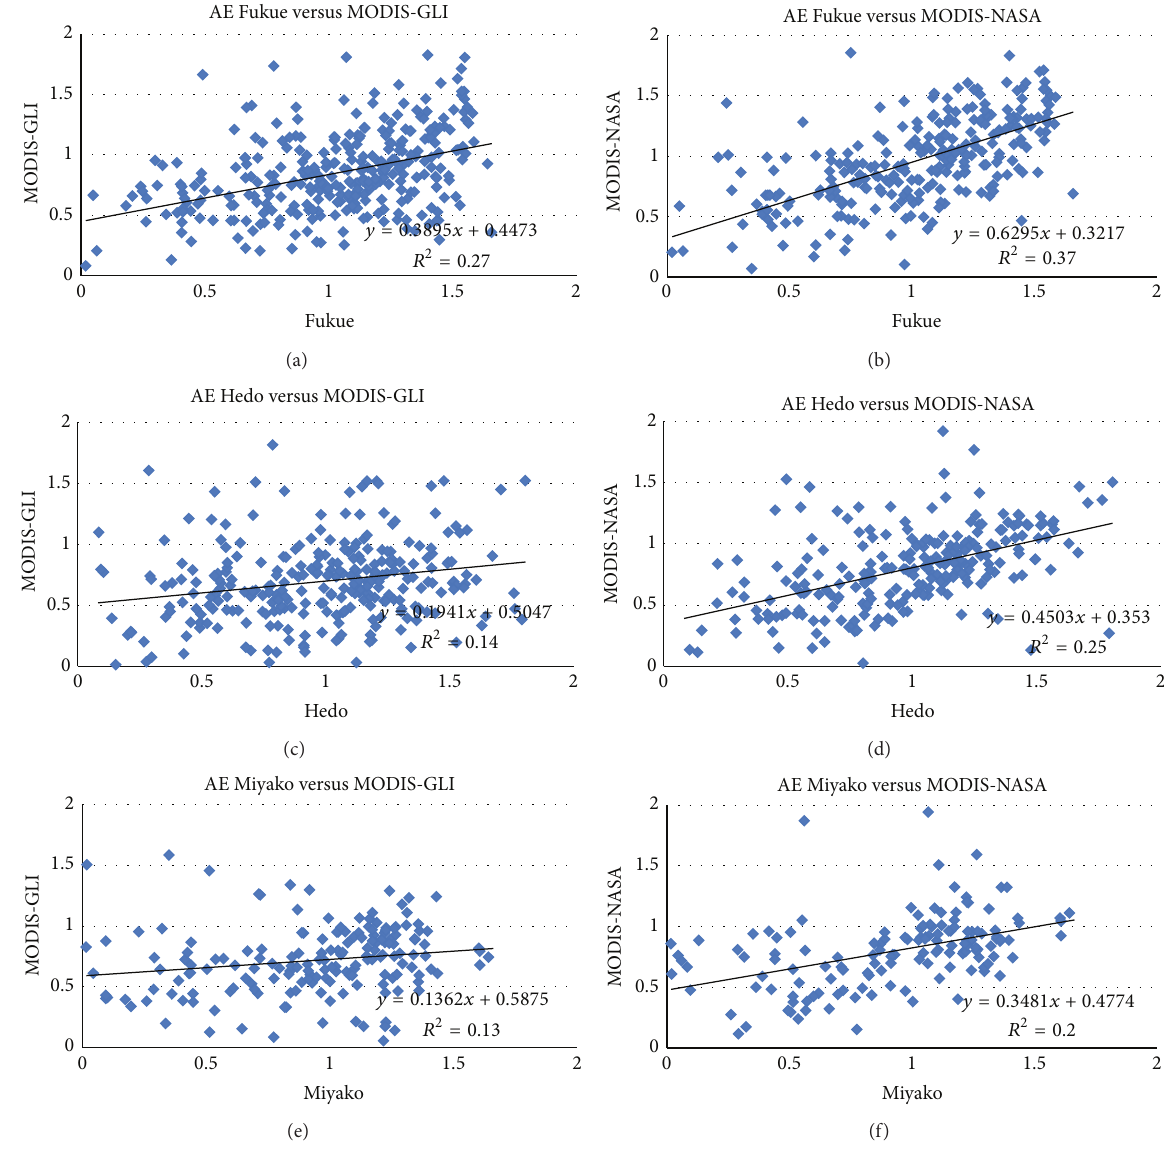
Figure 3: Scatter diagrams between ground (Fukue, Hedo, Miyako) and satellites’ derived aerosols AE. Ground data are on the 𝑥 -axis while satellite derived data (from both algorithms, MODIS-GLI and MODIS-NASA) are on the 𝑦 -axis. The AE is the ˚Angstr¨om